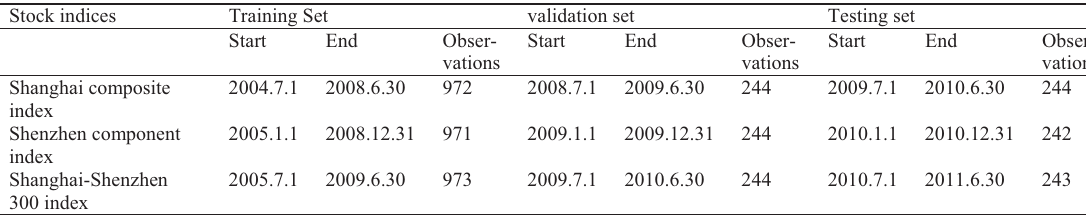
Table 1. Time series: training set, validation set and testing